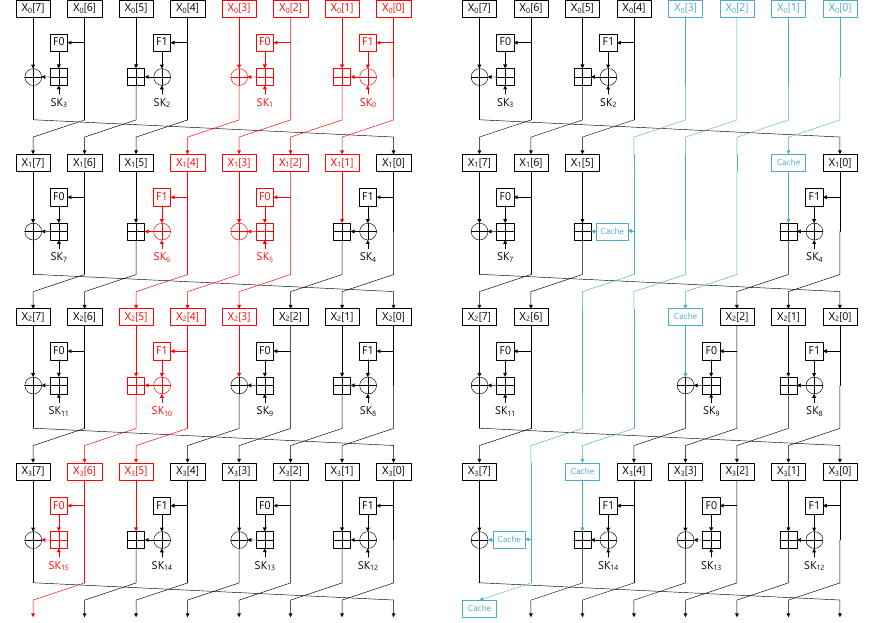
Figure 2. Counter mode of operation for HIGHT, ( left ) red colored routes represent the constant nonce part, ( right ) blue colored routes represent the optimized